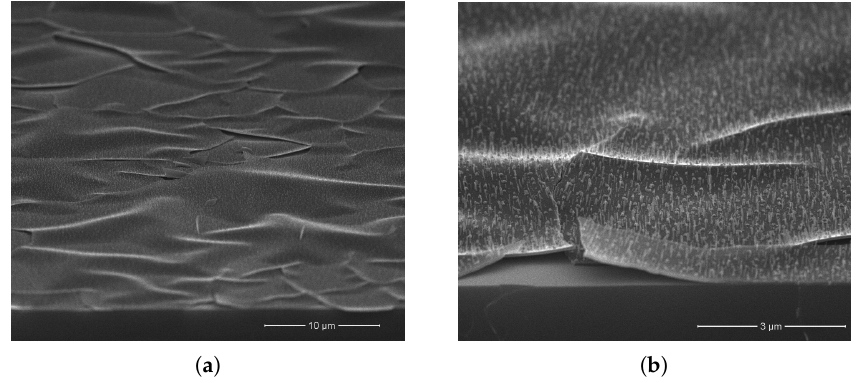
Figure 1. Cross-section micrographs at ( a ) 7000 × and ( b ) 30,000 × magnification of a cracked/wrinkled TiN supporting layer after being subjected to CNT growth at 700 ◦